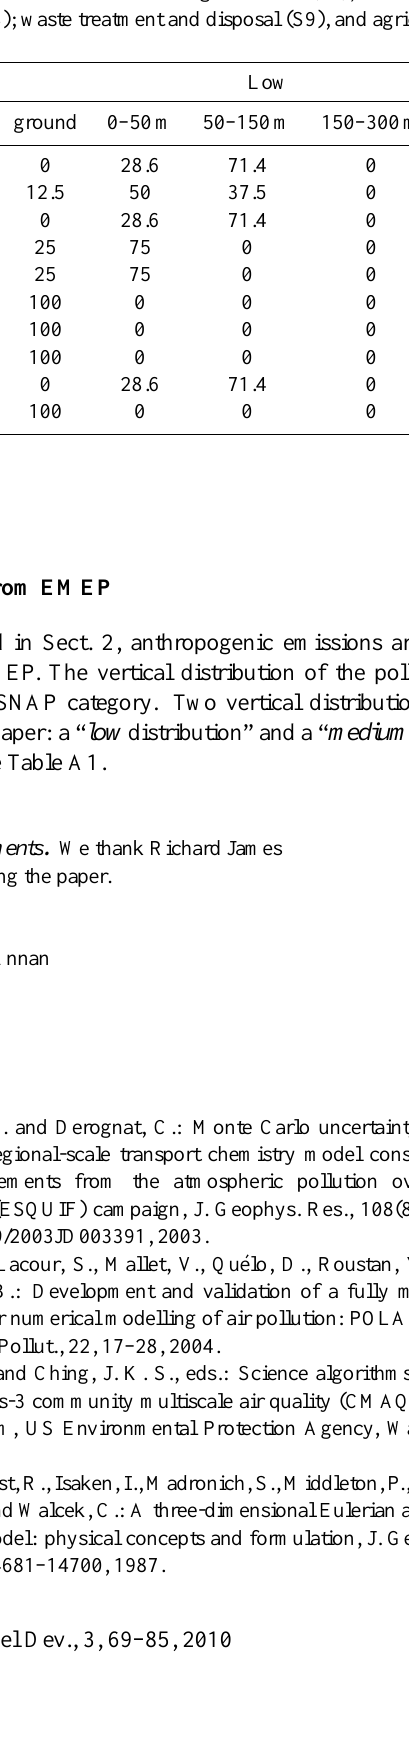
Table A1. Emission distribution in percentages for each level and for each SNAP category. Combustion in energy and transformation industries (S1); non-industrial combustion plants (S2); combustion in manufacturing industry (S3); production processes (S4); extraction and distribution of fossil fuels and geothermal (S5); solvent use and other product use (S6); road transport (S7); other mobile sources machinery (S8); waste treatment and disposal (S9), and agriculture